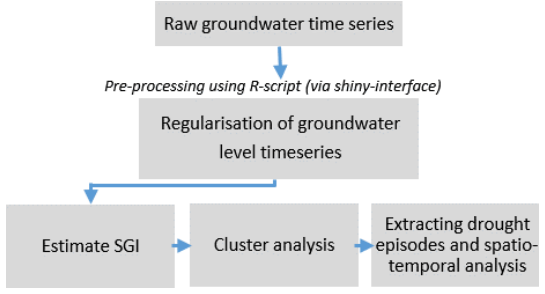
Figure 2. Methodology of data analysis.